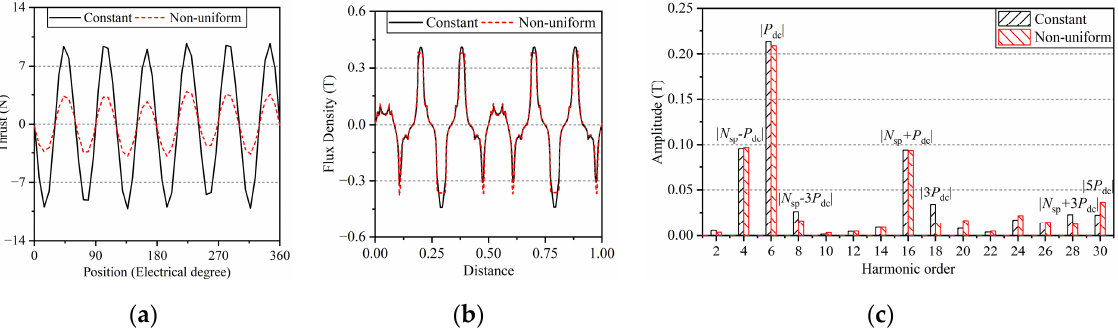
Figure 10. The detent force ( a ), the normal magnetic flux of air gap ( b ) , and its harmonic order ( c ) of DCB ‐ VRLM with the constant and non ‐ uniform air gap.